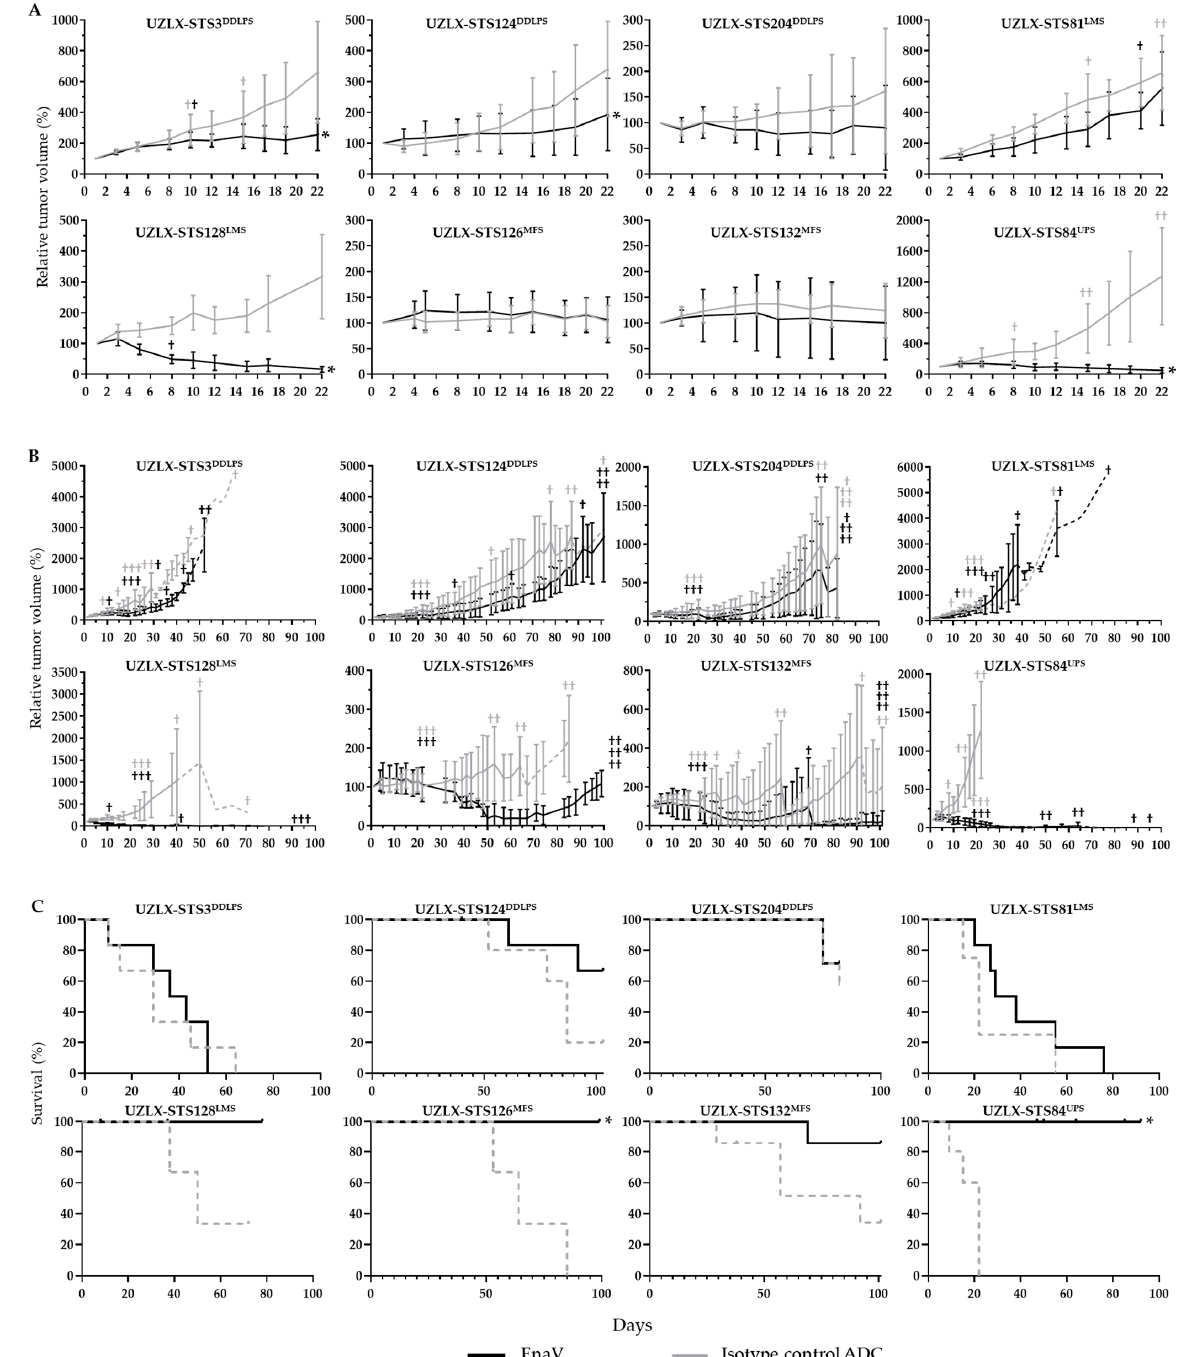
Figure 3. Tumor volume evaluation curves and survival curves of all sarcoma patient-derived sarcoma xenografts included in this study: ( A ) average relative tumor volume ± standard deviation (%) until day 22 and ( B ) average relative tumor volume (%) until day 100. Statistical significance as determined by unpaired t-test. Dotted lines represent data from less than three animals. Number of †: number of mice sacrificed during the experiment. ( C ) Kaplan-Meier curves with statistical significance as determined by log-rank test. Animals that were sacrificed because of body weight loss >18%, found dead or that reached the end of observation were censored. Mice sacrificed for histological evaluation day 22 (3 mice/group) were included in tumor volume evaluation but excluded from survival analysis. * p < 0.05 compared to isotype control